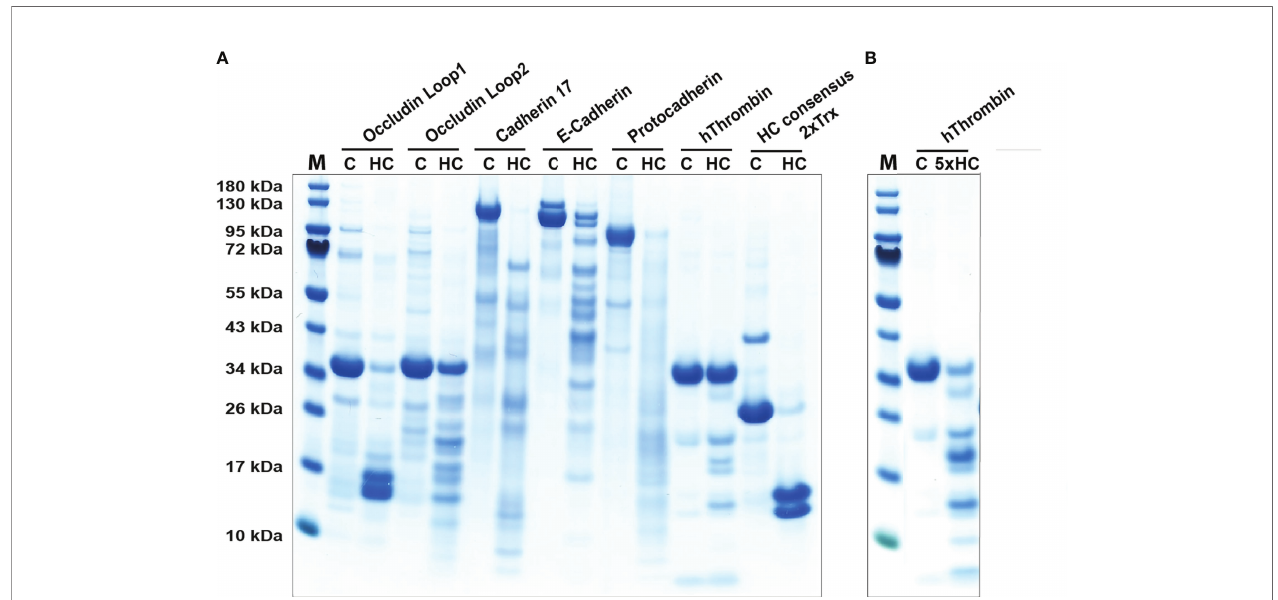
FIGURE 4 | Cleavage of adhesion molecules and thrombin by the human chymase. An SDS-PAGE analysis of a cleavage analysis of a panel of different cell adhesion molecules and of the coagulation factor thrombin by the human MC chymase. C marks the target protein without addition of the chymase, as control, and HC marks the cleavage of the target molecule by the human chymase. As a control for the activity of the human chymase is also a recombinant 2xTrx substrate included, where an optimal cleavage site for this enzyme is inserted between two copies of the E. coli redox protein thioredoxin (43). In panel (A) forty ng of HC was used in each of the cleavage reactions. In panel (B) which is a second cleavage reaction included of thrombin, there we used fi ve times higher amount, or 200 ng, of the human